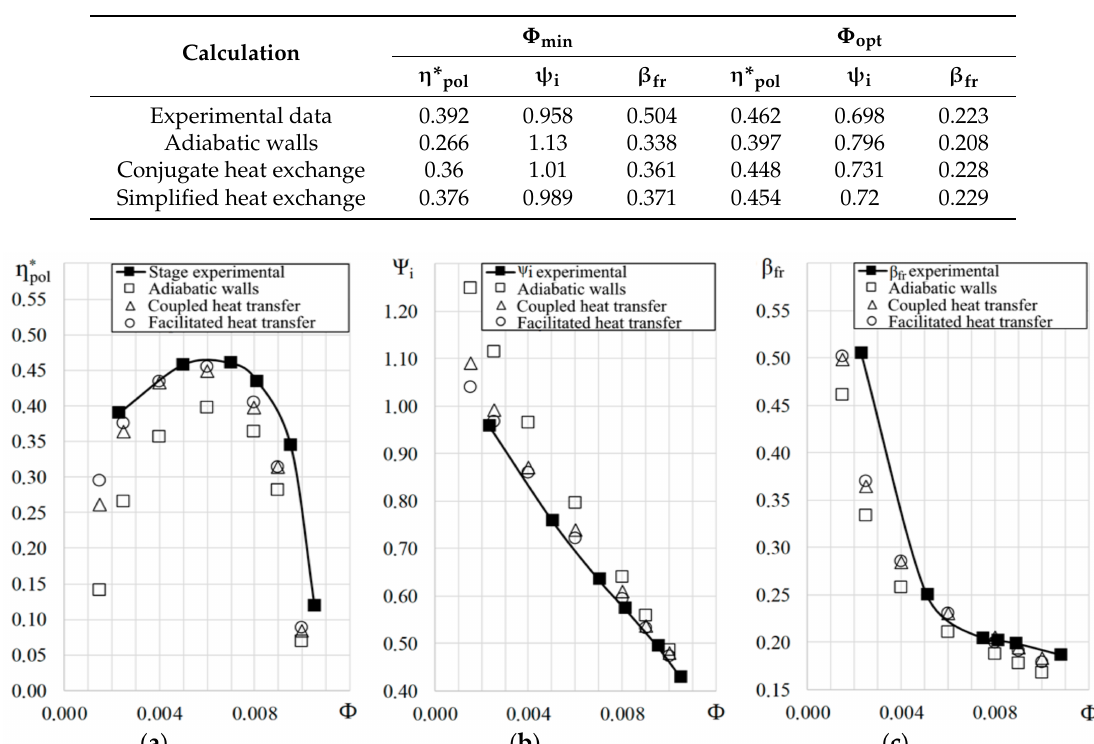
Table 1. Calculation results.